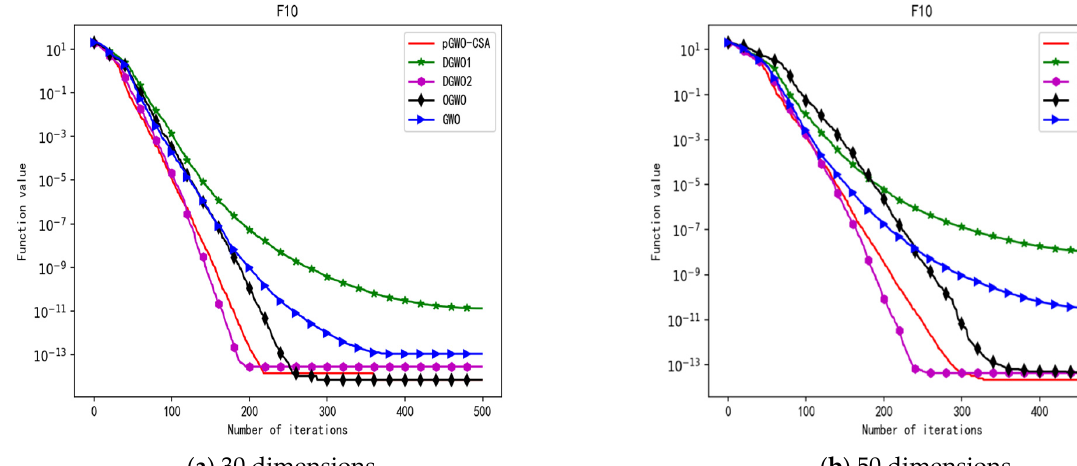
Figure 29. Convergence curve of test function F10.